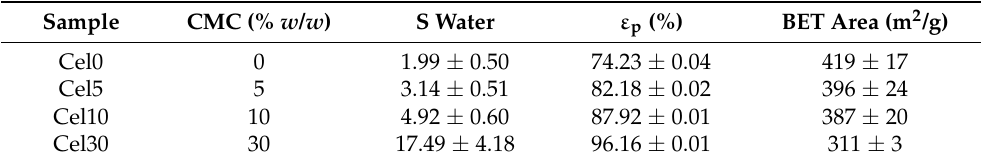
Table 1. Summary of dry polymer blends with a specified cellulose–carboxymethyl cellulose (CMC) % ( w / w ) giving rise to porous hydrogels beads. The average swelling degree (S), porosity ( ε p ) and BET (Brunauer–Emmett–Teller) area for the different beads for cellulose–CMC hybrid beads are reported with the standard deviations. Measurements of S and ε p were performed on 18 beads/sample. Nitrogen adsorption isotherms were made in